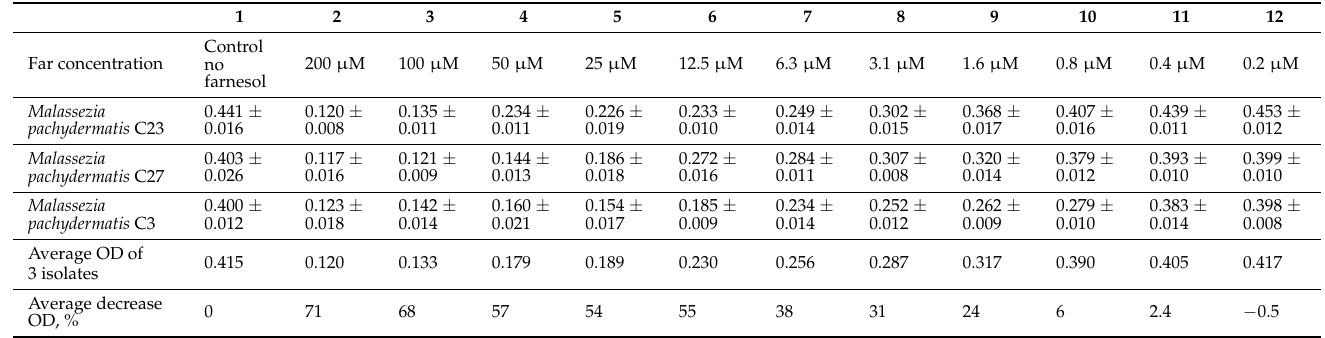
Table 4. The effect of different concentrations of Farnesol on Malassezia pachydermatis biofilms and optical density average decrease,% densitometric